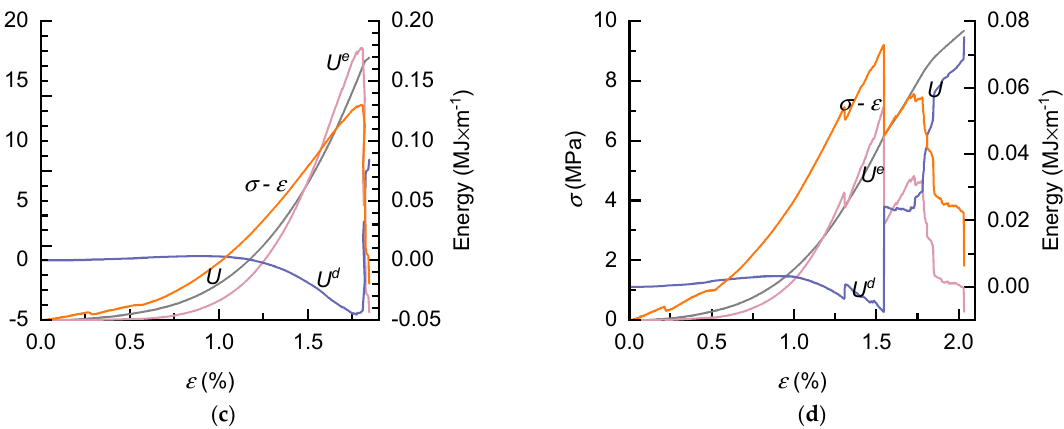
Figure 14. Water content of different coal sample stresses and energy diagrams. They should be listed